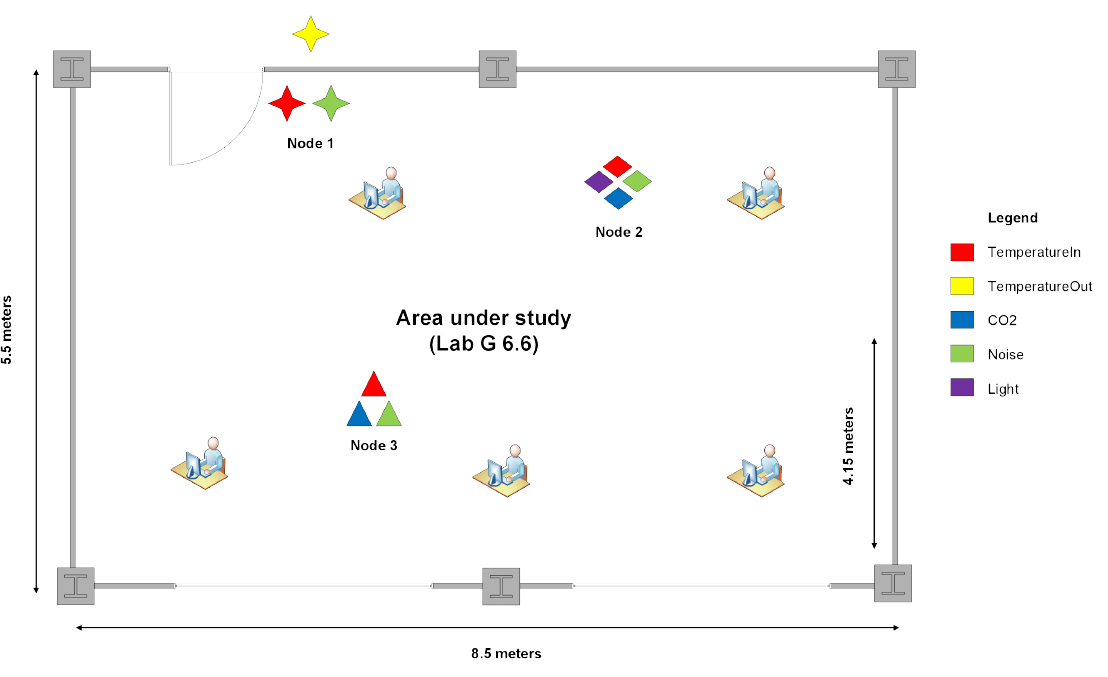
Figure 4. Nodes and sensors